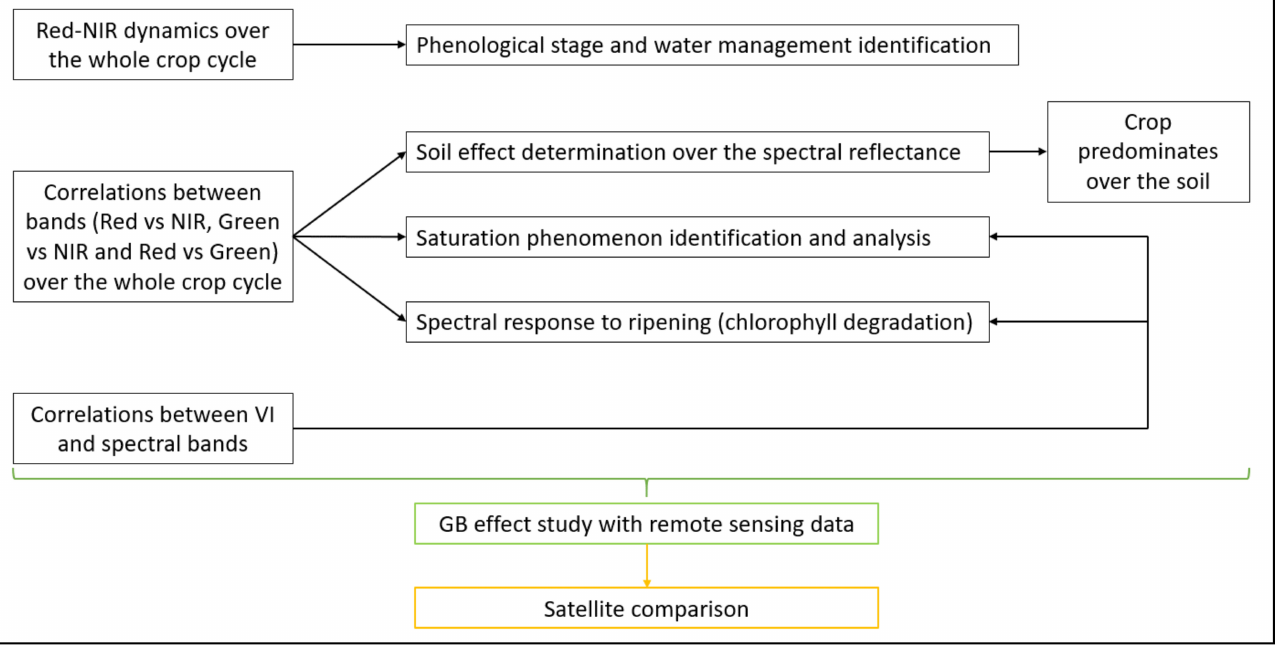
Figure 4. The workflow followed in the remote sensing monitoring presented in this